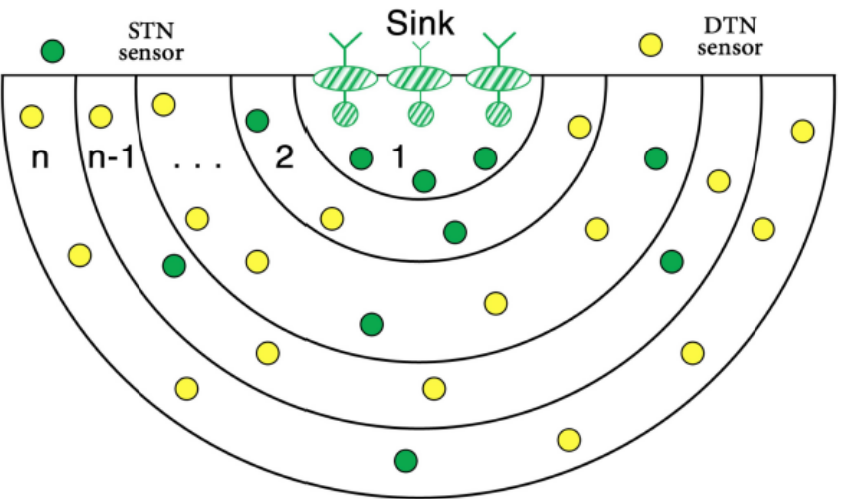
Figure 13. Layering structure in TORA at the node localization phase [53].